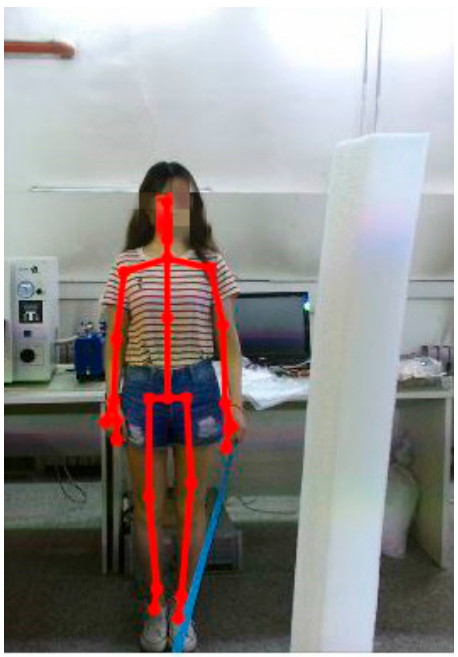
Figure 5. Occlusion experimental setup.